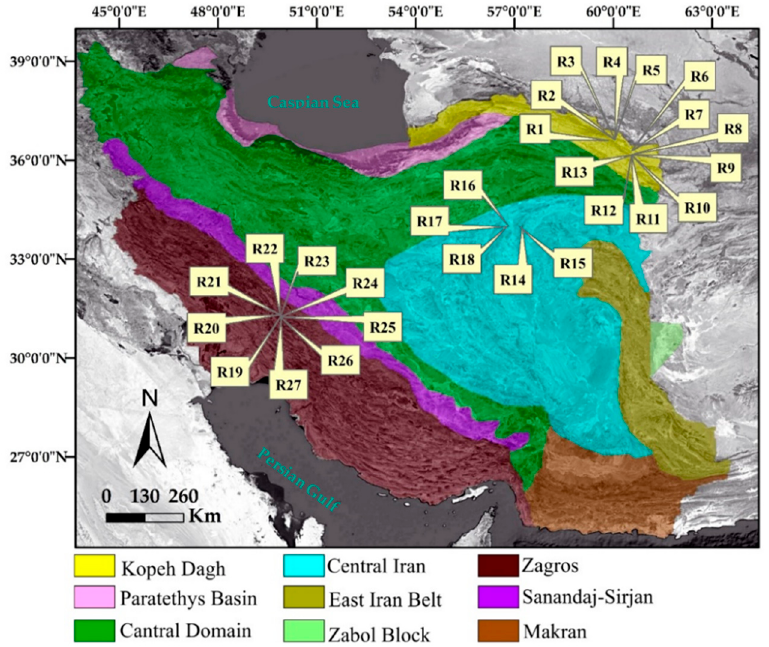
Figure 1. Main sedimentary structural zones of Iran (modified from Aghanabati 2004 [33]) and the location of the studied rock samples. Table 2. Age, sampling zone, and type of